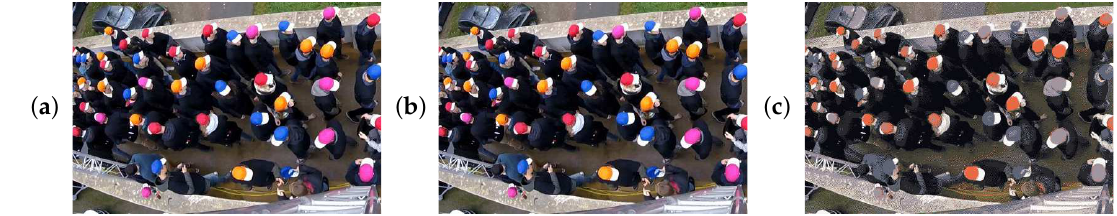
Figure 8. Part of a snapshot reduced to a different amount of colors: ( a ) original frame, 256 3 colors, ( b ) 1000 colors, and ( c ) 10